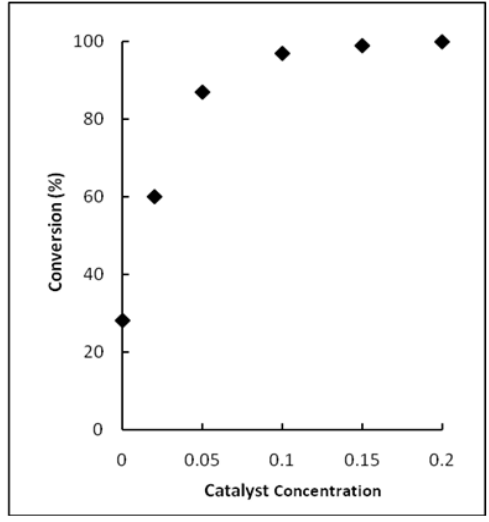
Figure 3. Conversion (%) of esterification of stearic acid with ethanol over KSF/0 catalyst versus catalyst concentration at 150 °C.